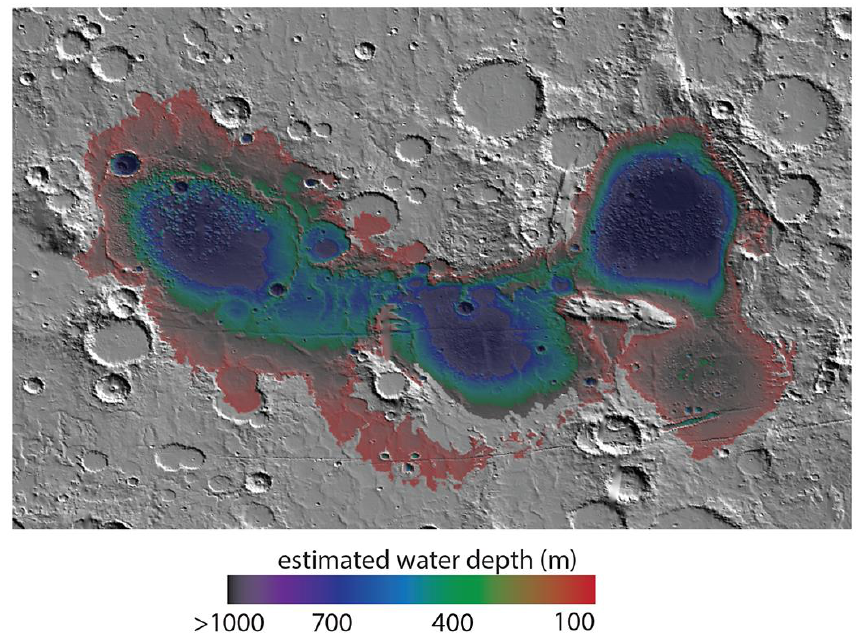
Figure 4. Map showing estimated water depth in different parts of the Eridania Sea. This map is about 530 miles across.